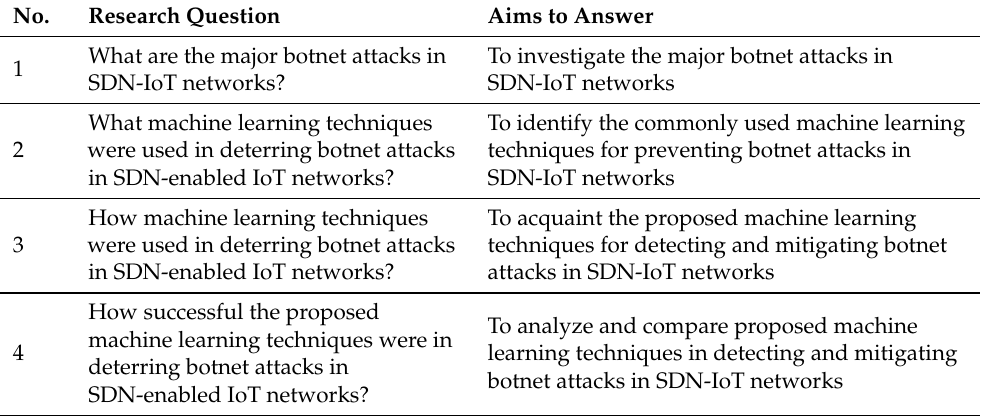
Algorithm 1: Pseudocode for Defining Search String